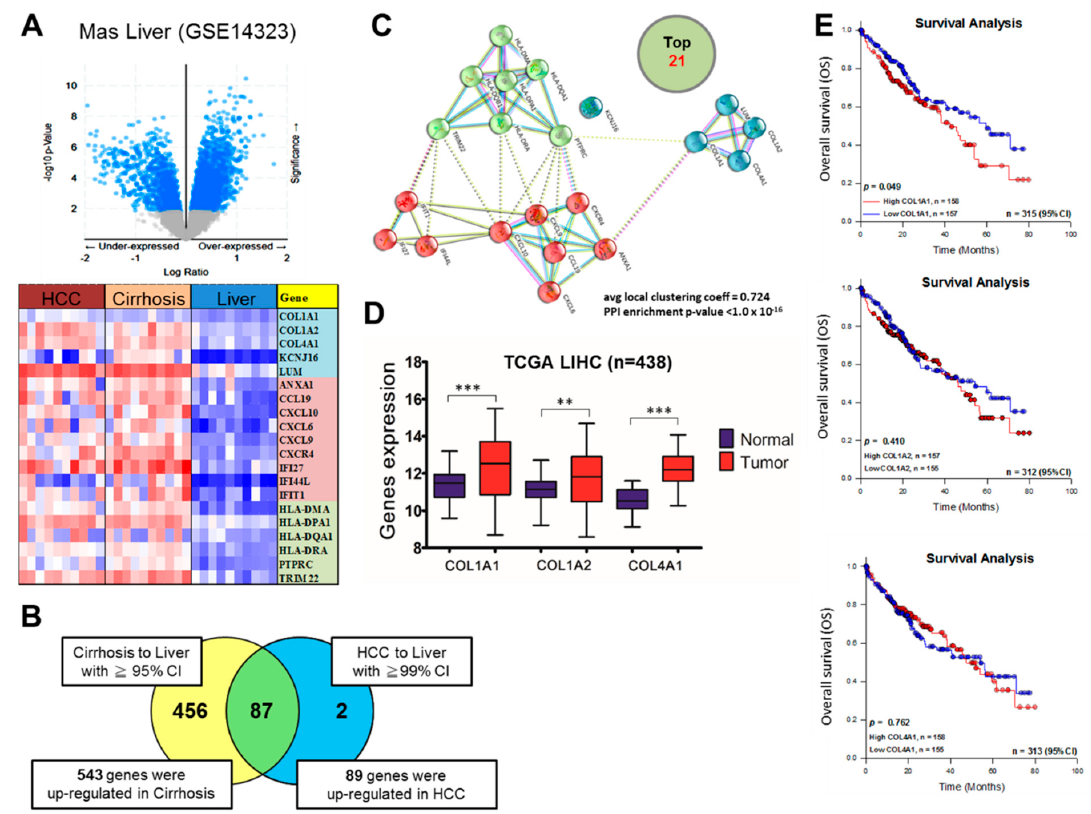
Figure 1. COL1A1 is highly expressed in hepatocellular carcinoma (HCC) and confers a significant survival disadvantage. ( A ) Volcano plot (upper panel) and heat map (lower panel) showing the differential expression of different genes expression in HCC, cirrhosis and normal liver tissue samples from the GSE14323 dataset. ( B ) Venn diagram showing that of the 543 and 89 genes upregulated in cirrhosis and HCC, respectively, 87 genes were common to both cirrhosis and HCC. ( C ) Functional protein–protein interaction of the top 21 of 87 co-upregulated genes as depicted by Search Tool for the Retrieval of Interacting proteins database (STRINGdb). ( D ) Graphical representation of the differential expression of COL1A1, COL1A2 and COL4A1 in normal liver or HCC samples from The Cancer Genome Atlas (TCGA) liver cancer hepatocellular carcinoma (LIHC) ( n = 373). ( E ) Kaplan–Meier plots of the effects of high or low expression of COL1A1 (upper), COL1A2 (middle) or COL4A1 (lower) on the survival rates in the TCGA LIHC cohort. Median gene expression was used to determine low/high cut-off value. ** p < 0.01, *** p < 0.001.